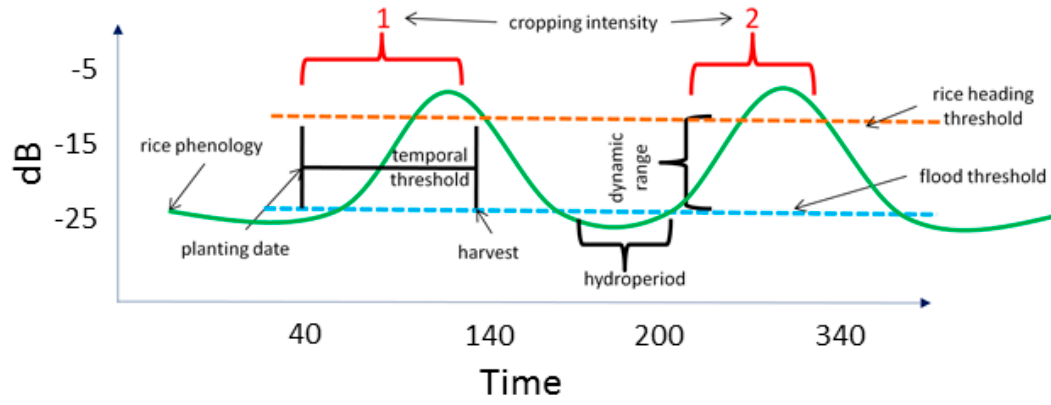
Figure 4. Conceptual Sentinel-1 double rice signature with key indicators highlighted from management (i.e., inundation) and rice growth stages (i.e., biomass development and dynamic range).